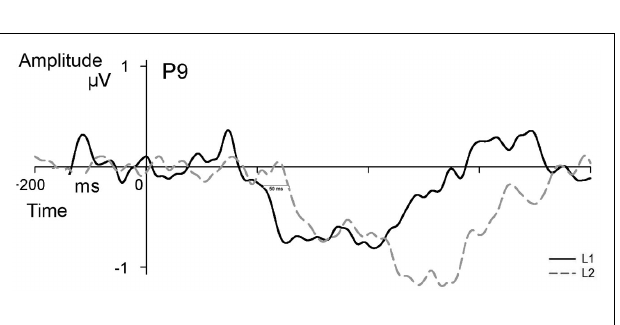
FIGURE 4 |The Latency Shift of early posterior Negativity (EPN) Emotion Effects between L1 and L2 for 40 German Participants: Superimposed DifferenceWaves ofActivation forWords of different emotionalValence (positive minus neutral) in first (L1) and second (L2) Language Processing at Electrode P9 (representative for the